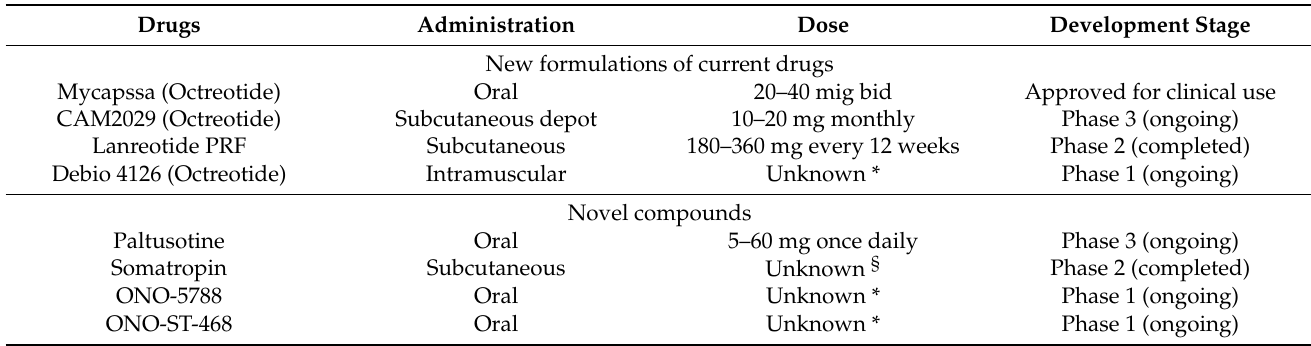
Table 1. Novel SRLs under